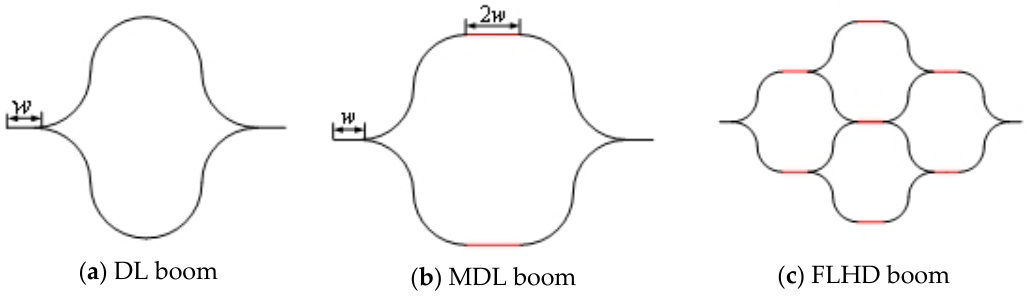
Figure 1. Three kinds of composite deployable booms.